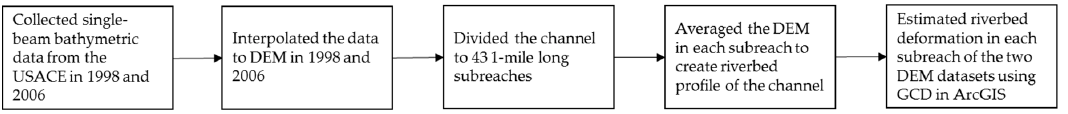
Figure 2. Left : Raw single beam survey data used to develop the riverbed digital elevation model (DEM). Right : DEM data were generated through interpolation for the uppermost 69-km Atchafalaya